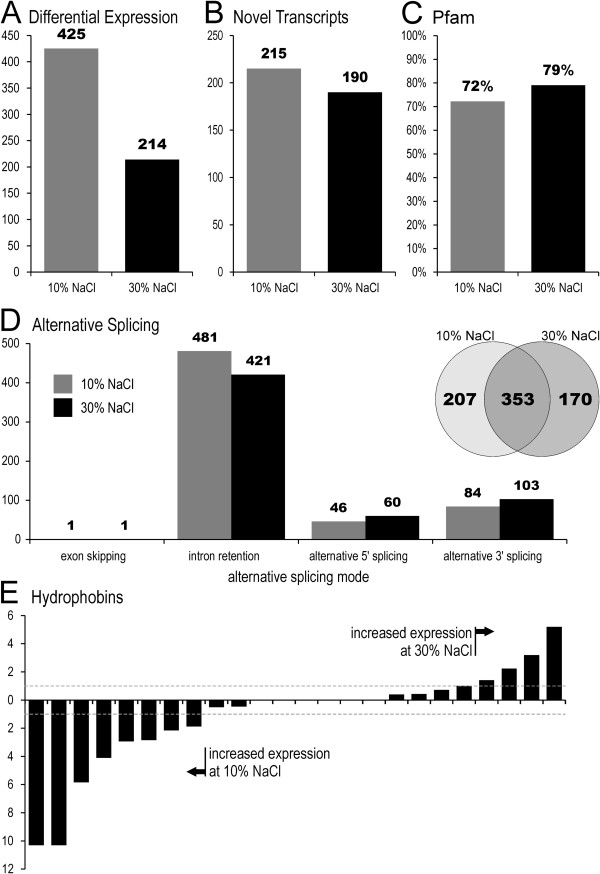
Transcriptome of Wallemia ichthyophaga at 10% NaCl and 30% NaCl (w/v). A. Number of genes with increased expression at each salinity, compared to the other salinity. B. Number of novel transcripts predicted at each salinity. Gene models at least 200 bp away from known upstream or downstream genes were considered as novel transcripts. C. Proportion of proteins with increased expression at each salinity that were matched to at least one Pfam family. D. Number of genes with different alternative splicing modes at each salinity. Two intersecting circles show the number of genes with alternative splicing observed only at 10% NaCl, only at 30% NaCl, or at both (middle). E. Differences in expression of hydrophobins between the two salinities. Each bar represents a log2 ratio of expression at each salinity for an individual hydrophobin. All values above and below the dashed grey lines were considered as significantly differentially expressed.